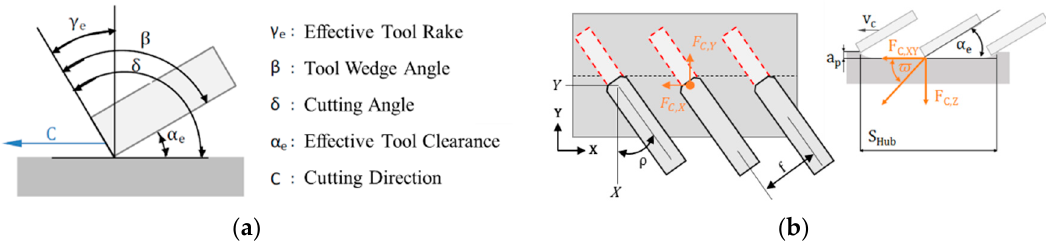
Figure 2. Directions, angles ( a ), and forces ( b ) of the hand scraping process following ISO 3002 and Schmid [9].